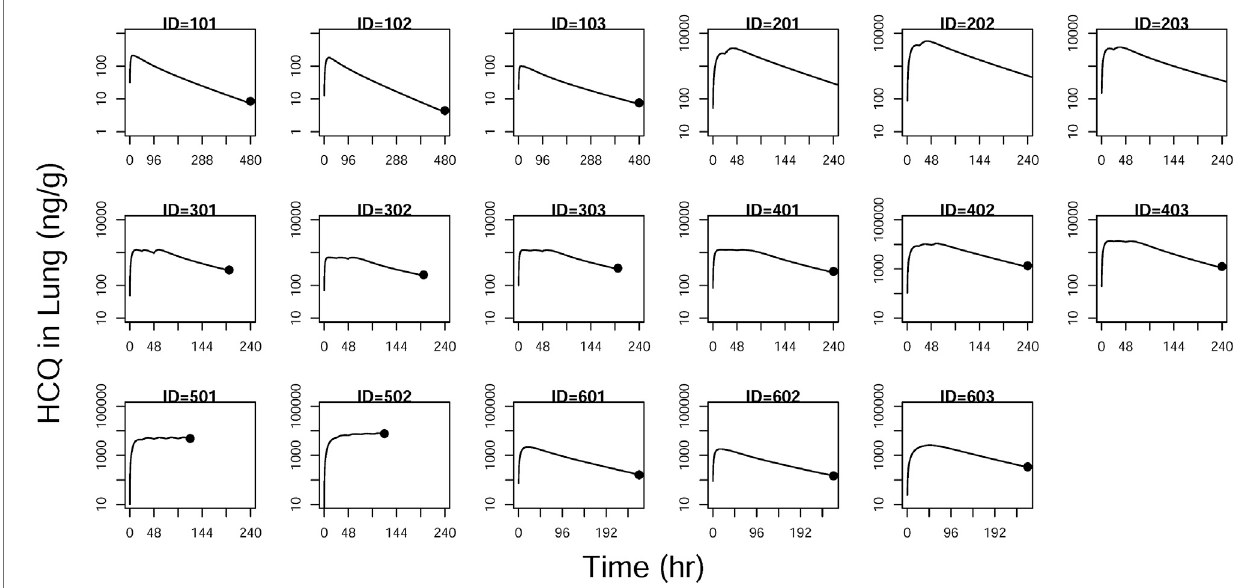
Frontiers in Pharmacology |